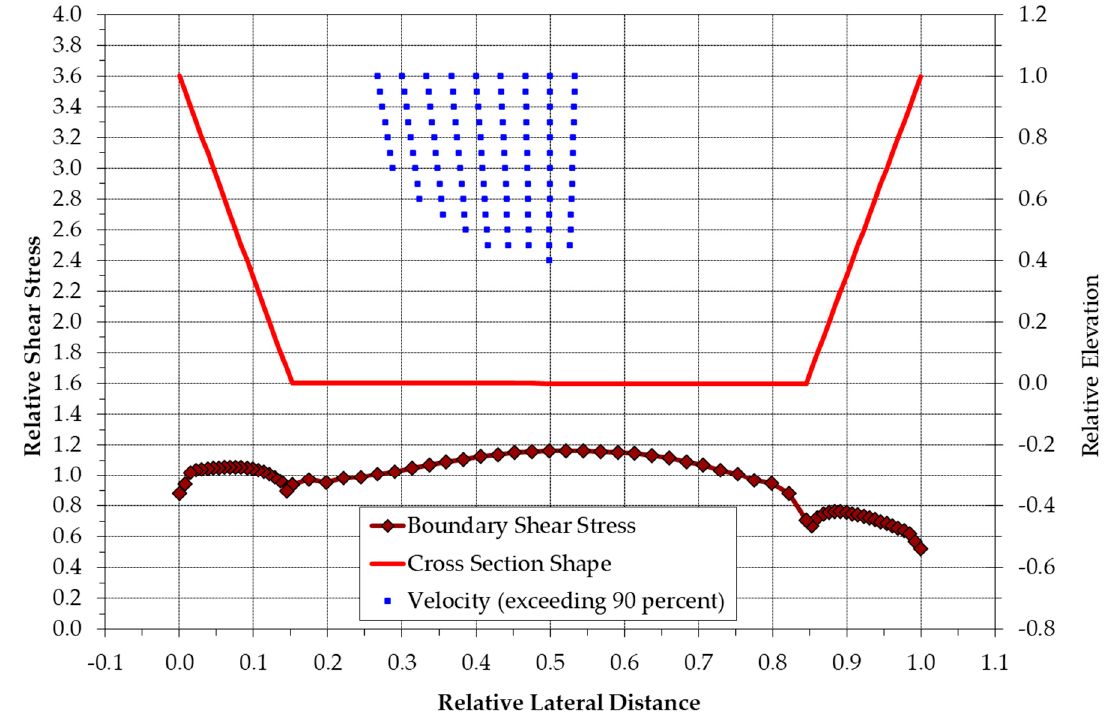
Figure 35. Cross-section 810 (3rd meander bend) lateral distribution of shear stress and zone where velocity is at least 90 percent of the maximum velocity.